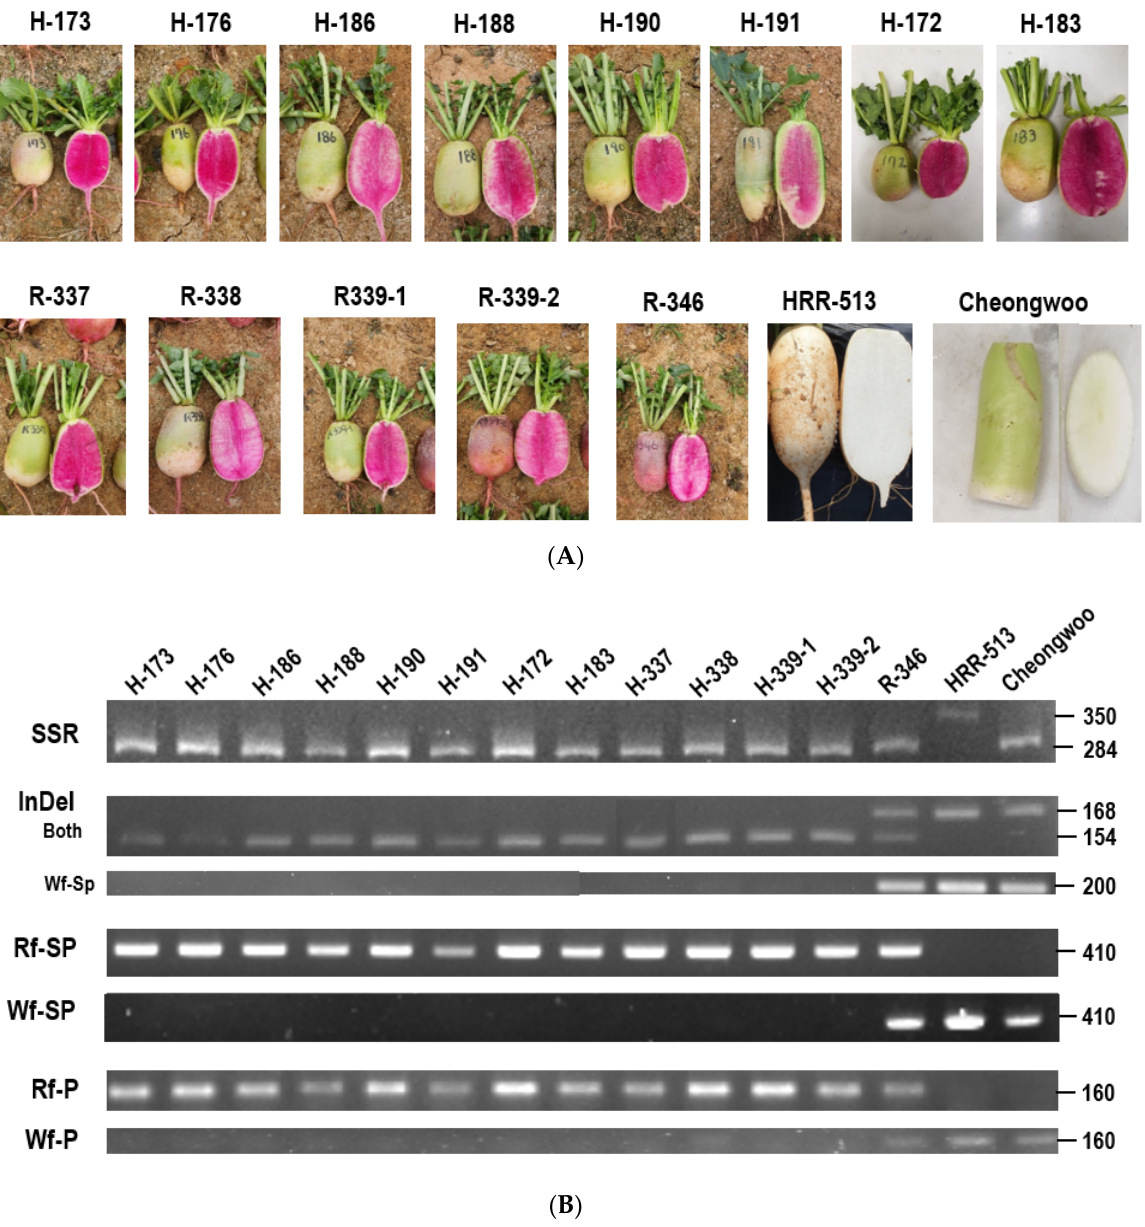
Figure 8. Validation of PCR ‐ markers using F 1 cultivars in Korea. H and R indicate inbred and recombinant lines, respectively, from Hankook Seed Co. Numbers on the right, denote size of band (bp). ( A ) Morphology of taproots used in this study. ( B ) Results of PCR amplification .